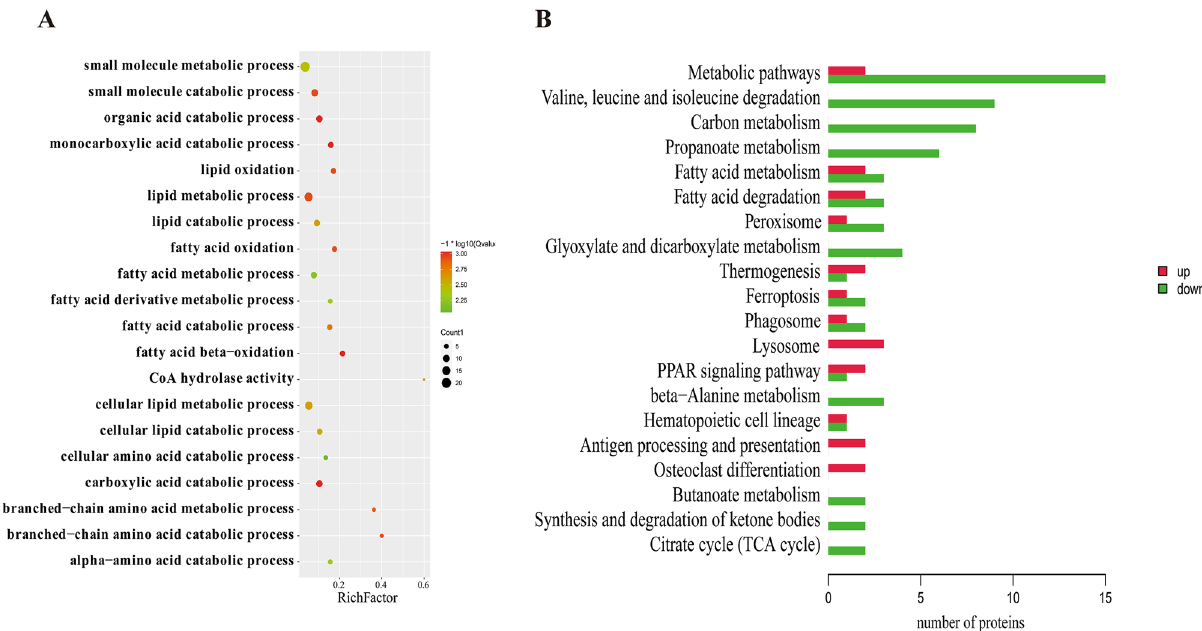
Figure 5. The GO and KEGG enrichment analysis of DAPs in subcutaneous fat. ( A ) GO enrichment analysis of DAPs between the HBF and LBF groups. The rich factor is the ratio of DAPs annotated in a pathway term to the total proteins annotated in the same pathway term. Smaller P -values indicate higher significance. ( B ) KEGG enrichment analysis of DAPs. Red colors represent upregulated protein expression and green colors represent downregulated protein expression.